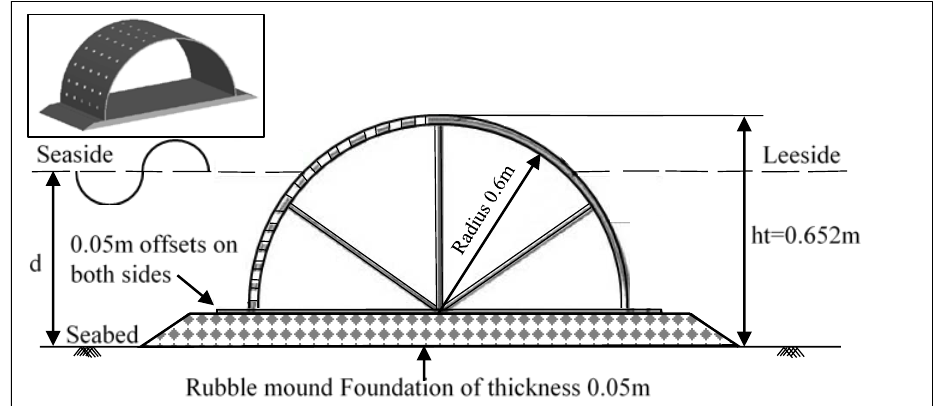
Figure 1. Cross-section of the semicircular breakwater model with a rubble mound foundation (data from [22]).